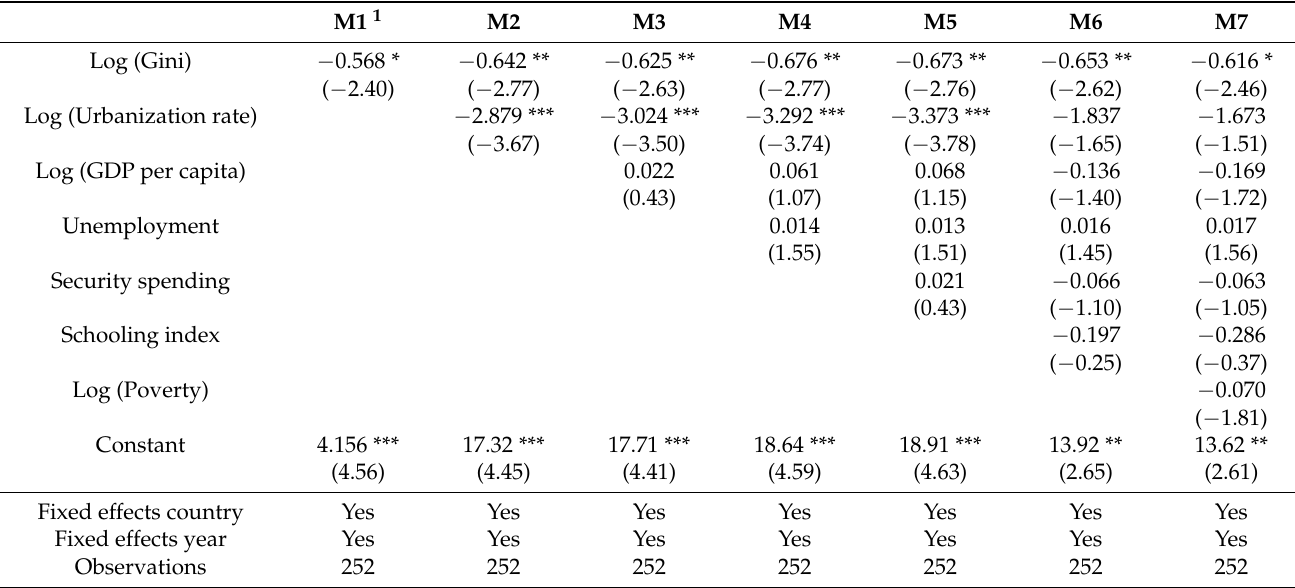
Table 4. Baseline regression of the GLS model with control variables for Latin American countries globally